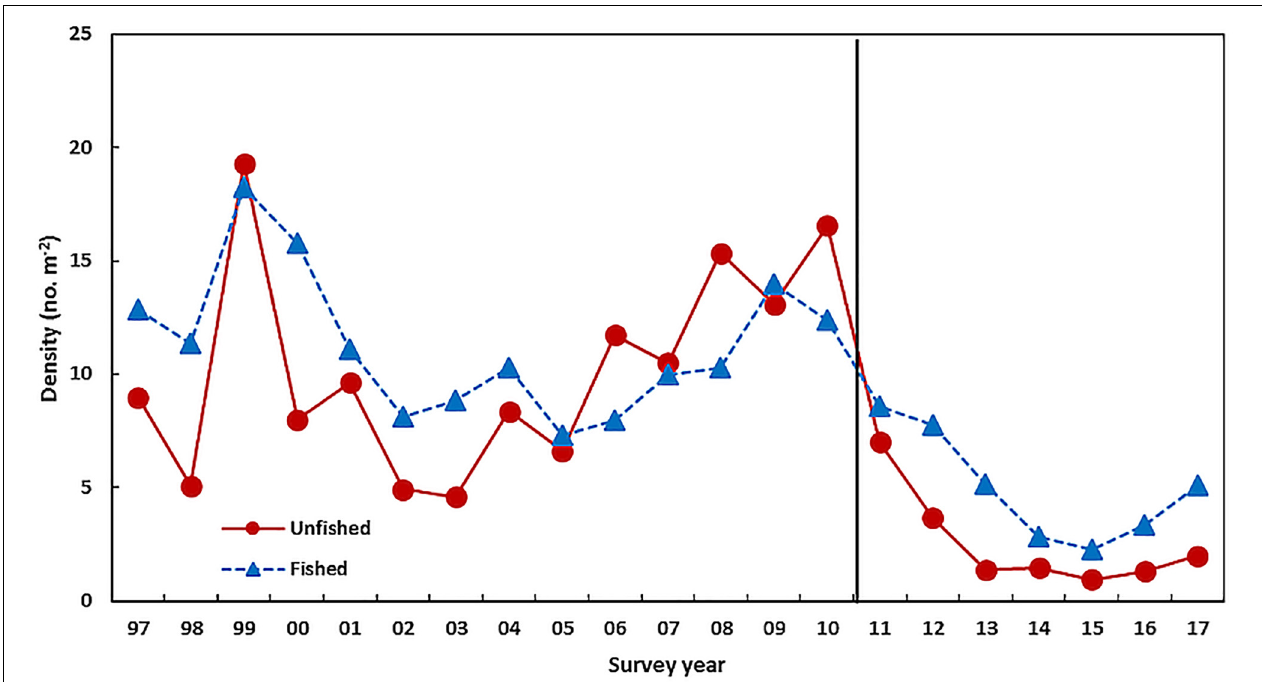
FIGURE 7 | The 1 + juvenile abundance from the Perth Roei abalone fishery-independent dive survey conducted in March each year averaged over a number of fished locations and an unfished area. The vertical line indicates the occurrence of the heatwave.